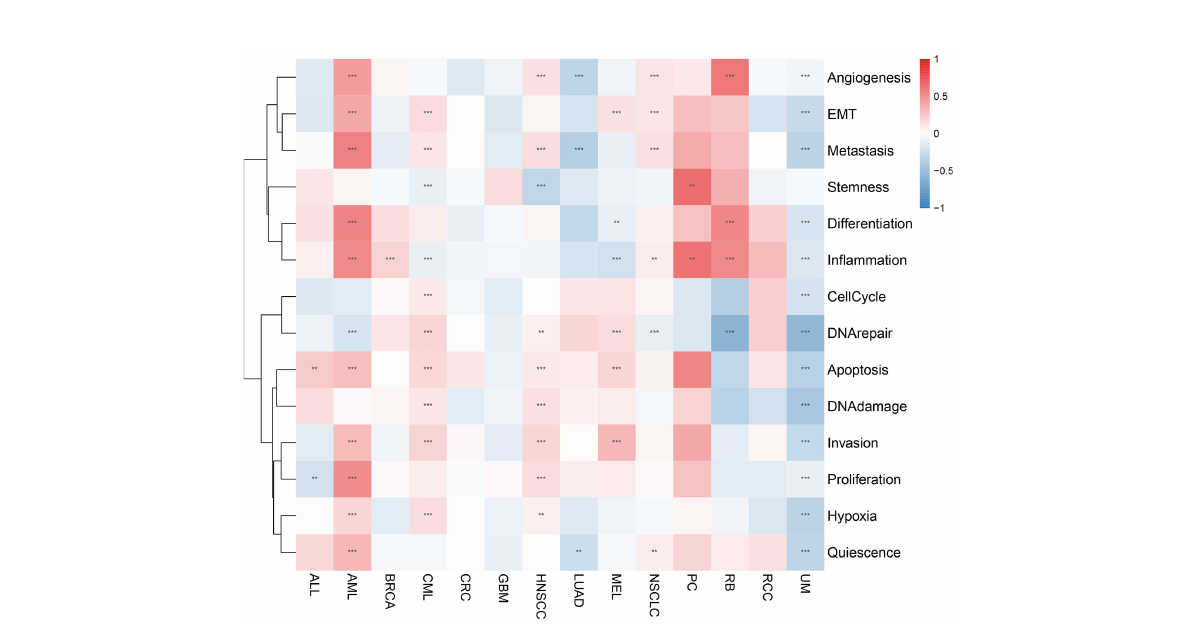
FIGURE 8 Correlation of the AIM2 in fl ammasomes scores with 14 functional status in different tumors. Red represents positive correlation and blue represents negative correlation. **p < 0.01, and ***p < 0.001 (Spearman ’ s correlation